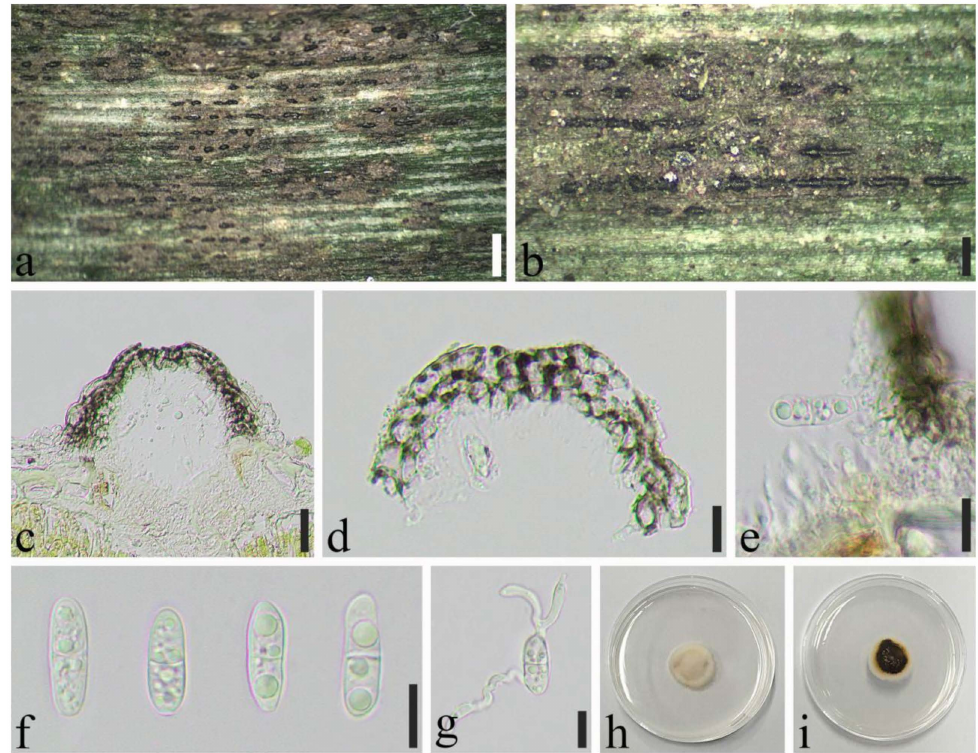
Figure 11. Paralloneottiosporina sichuanensis (SICAU 22-0075, paratype). ( a , b ) Conidiomata on the host. ( c ) Vertical sections of conidiomata. ( d ) Peridium. ( e ) Conidiogenous cells and developing conidia. ( f ) Conidia. ( g ) Germinating conidium. ( h , i ) Cultures on PDA. Scale bars: ( a ) = 500 µ m, ( b ) = 200 µ m, ( c ) = 20 µ m, ( d – g ) = 10 µ